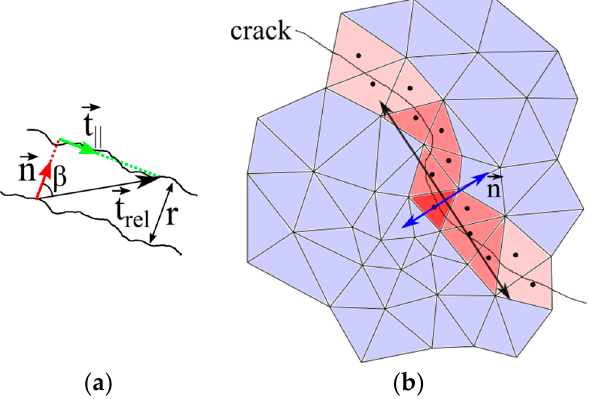
Figure 4. ( a ) The crack width r is computed by the projection of 𝑡⃗ (cid:3045)(cid:3032)(cid:3039) onto the normal 𝑛(cid:4652)⃗ ; ( b ) crack normal estimation according to [19,20].